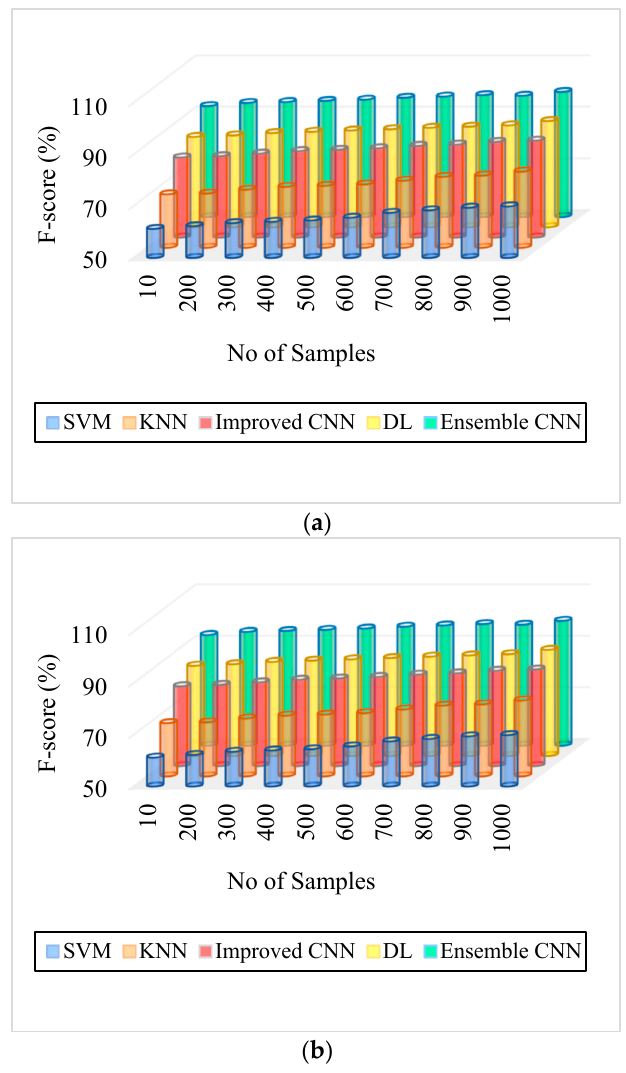
Figure 8. F-Score. ( a ) IDRiR and ( b ) Messidor.